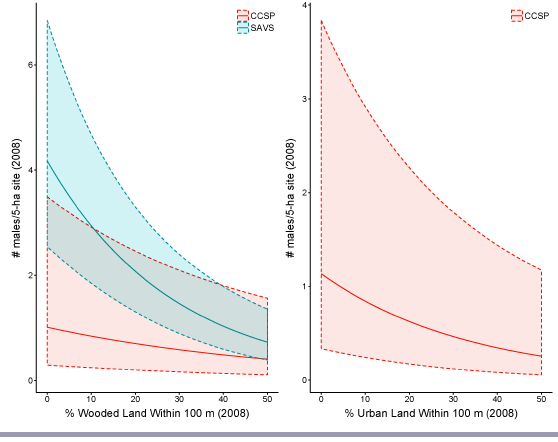
Fig. 3. Predicted relationship for Clay-colored Sparrow (CCSP) and Savannah Sparrow (SAVS) densities based on the percentage of land within 100 m of study sites consisting of wooded lands (trees or shrubs; both species) and urban land (CCSP only) in 2008.